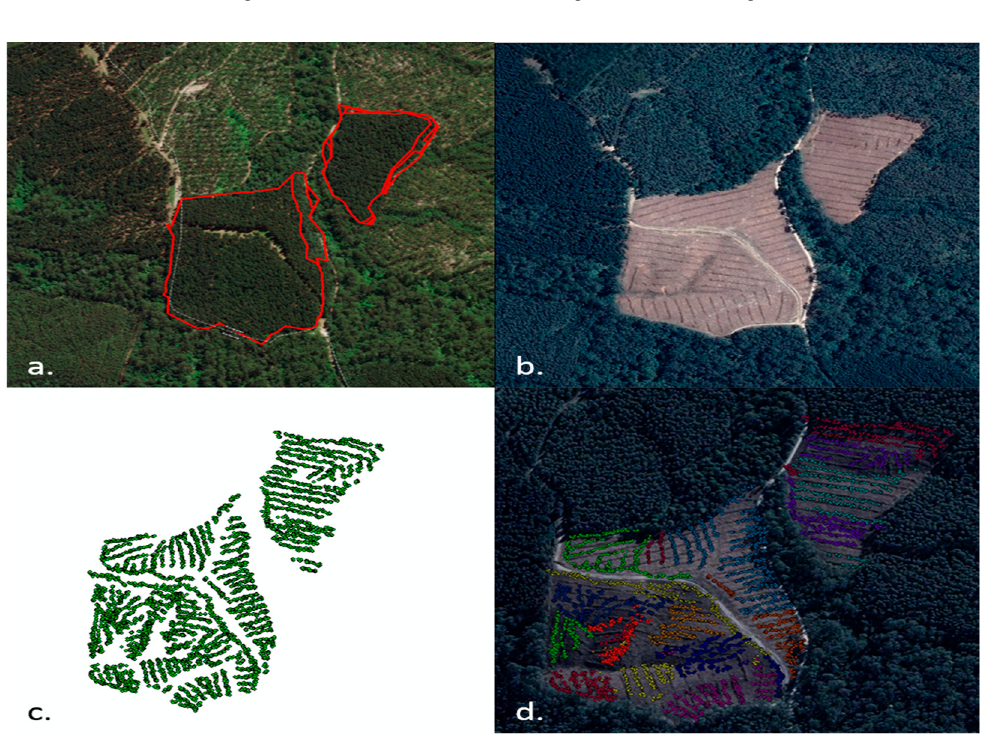
Figure 6. Map of harvesting operation generated from FIELD output data (( a ) study area before harvesting operation, ( b ) study area after harvesting operation, ( c ) reconstruction and generation of biomass availability map using FIELD, ( d ) biomass availability map overlapped with satellite image). Point data on the map (Figure 7) correspond to the location of individual trees.